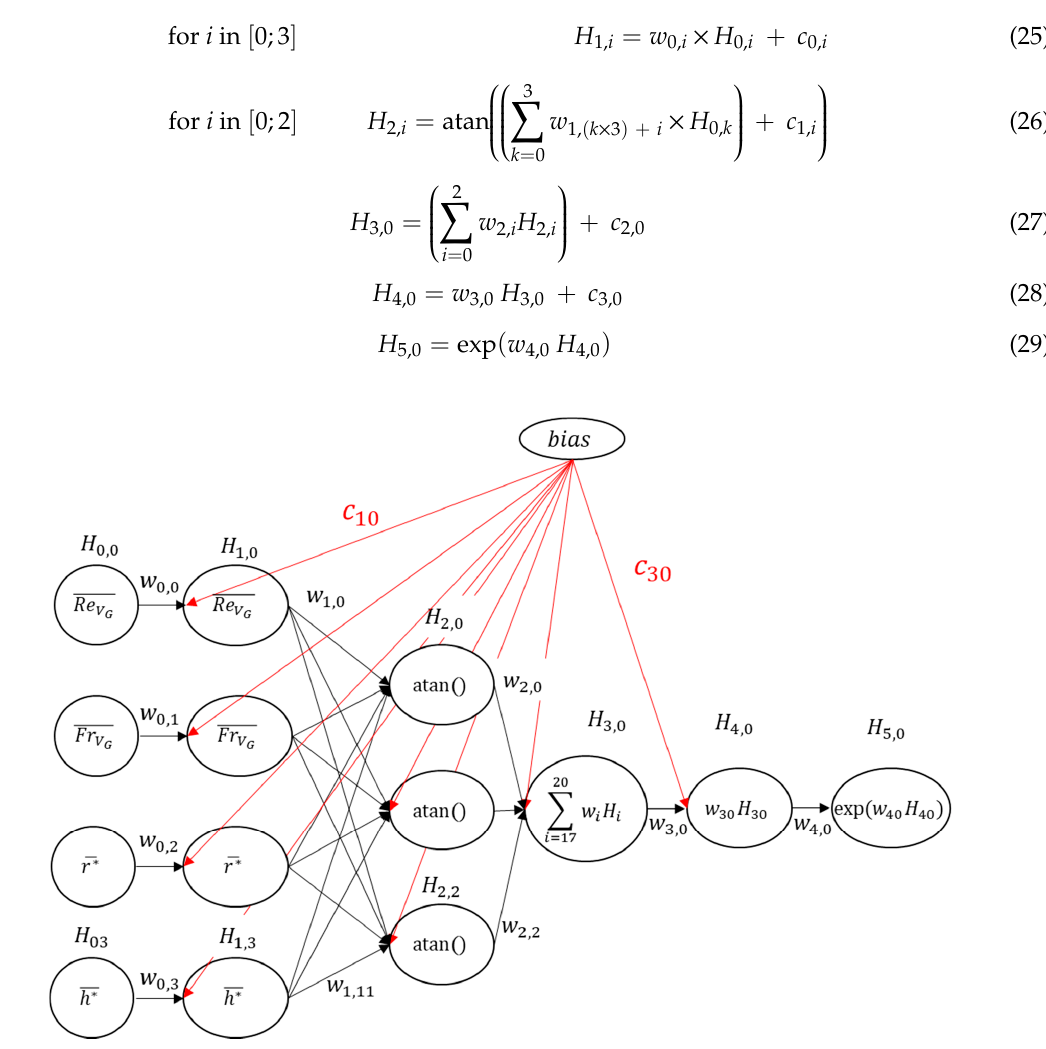
Figure 2. Architecture of the artificial neural network used to estimate the void fraction d. The parameters of Equations (25)–(29) are given in the Table